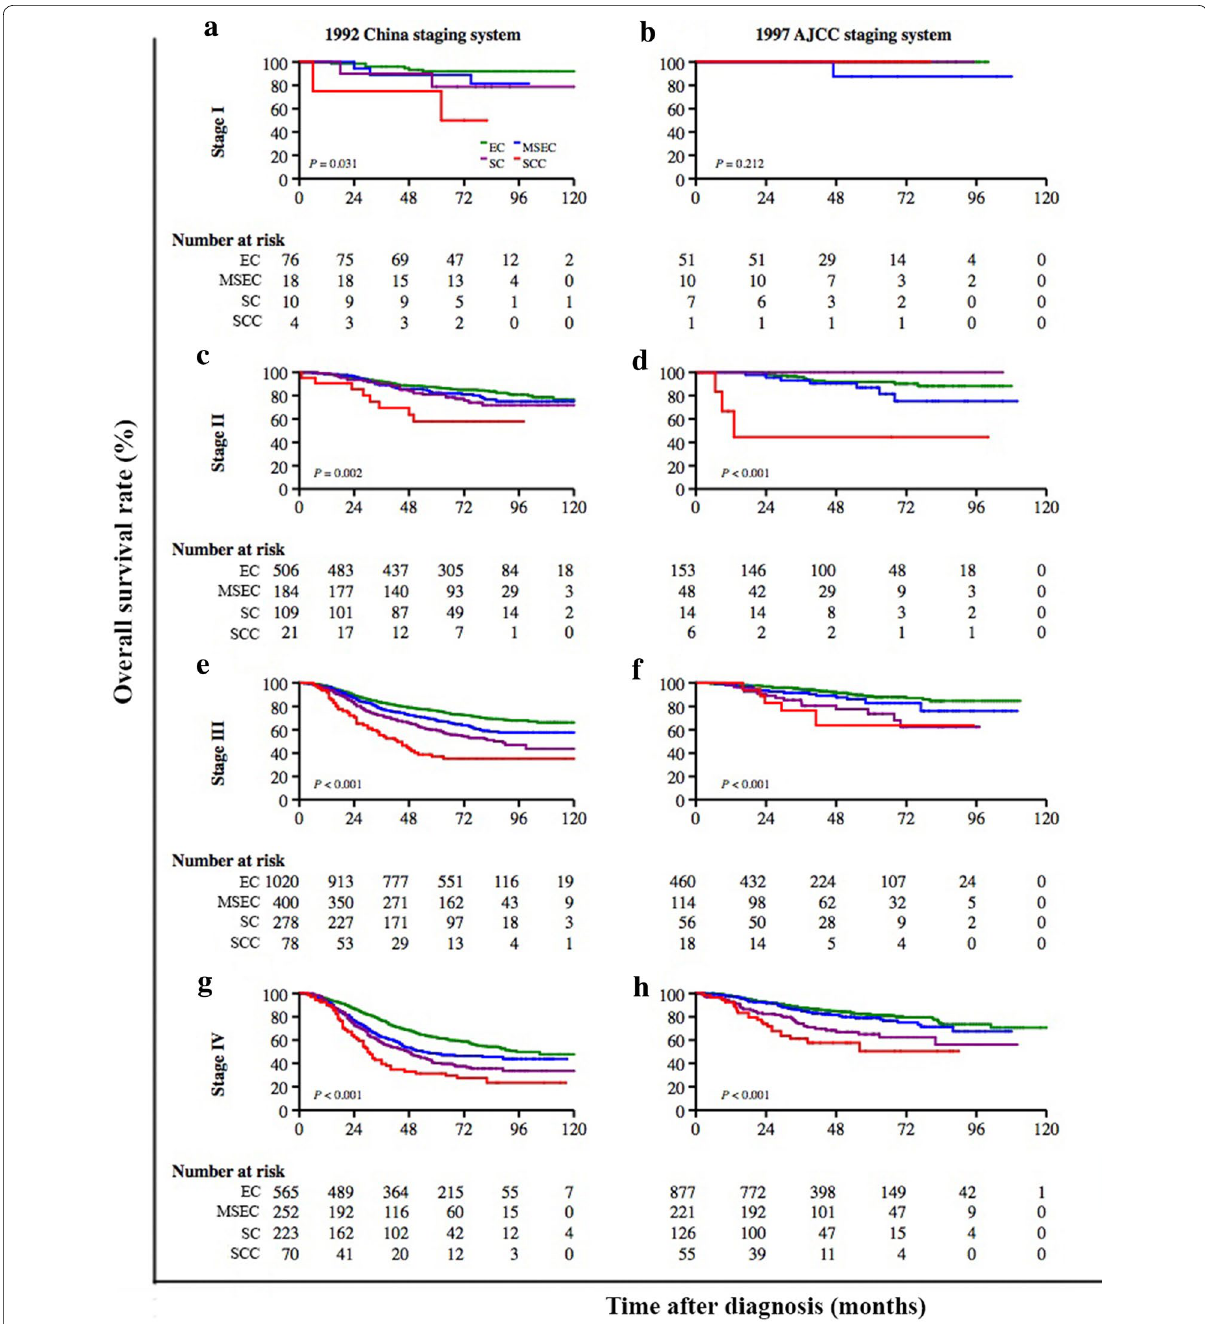
Fig. 8 Kaplan‑Meier survival estimates for NPC patients at different clinical stages according to two staging systems and stratified by subtypes according to the proposed classification. The OS differed significantly according to subtype of the proposed classification for patients at differ‑ ent clinical stages classified according to the 1992 China staging system ( P system (all P < 0.001, d , f , and h ), respectively. The log‑rank test was used to calculate P